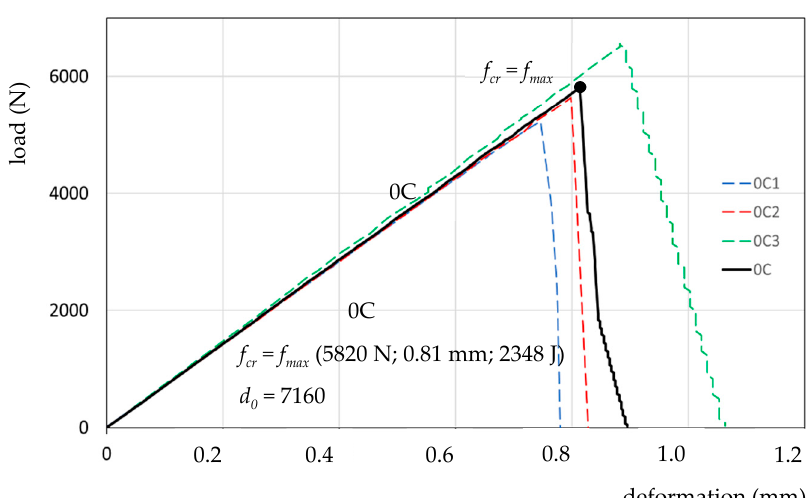
Figure 8. Presentation of load–deformation curves for expansion joint model specimens 0C1, 0C2, 0C3 and the reference specimen 0C in the axial tensile test.